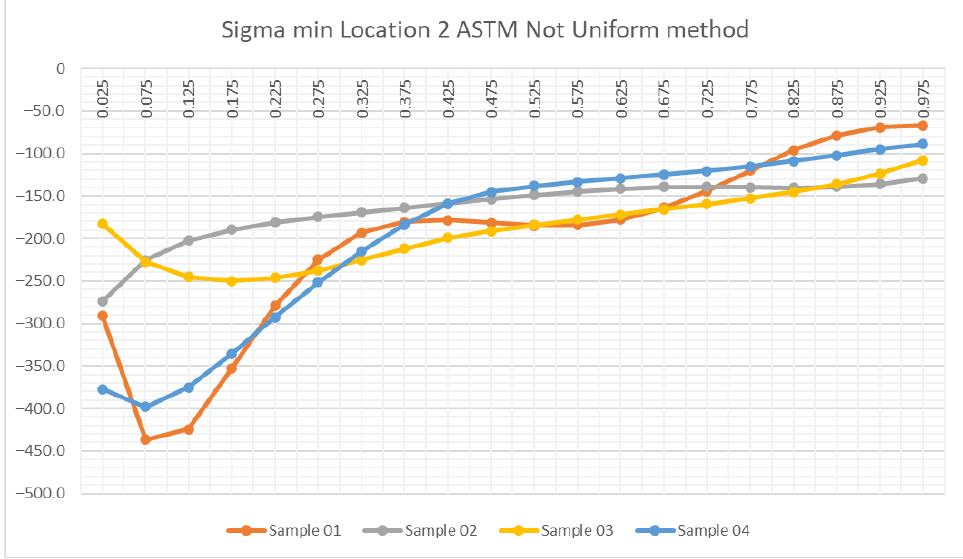
Figure 8. The resulting values of residual stresses (Sigma min) for all four samples at the measuring Location 2.